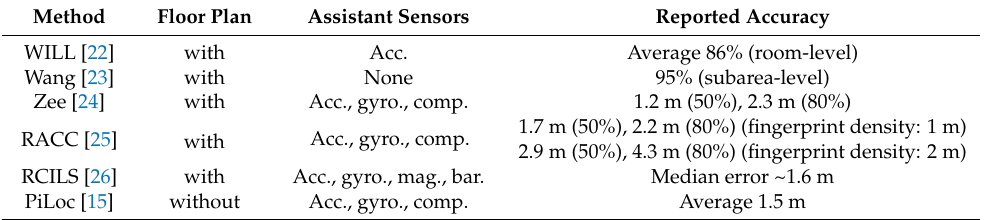
Table 1. Comparison of fingerprint localization methods without site surveys via passive crowdsourcing